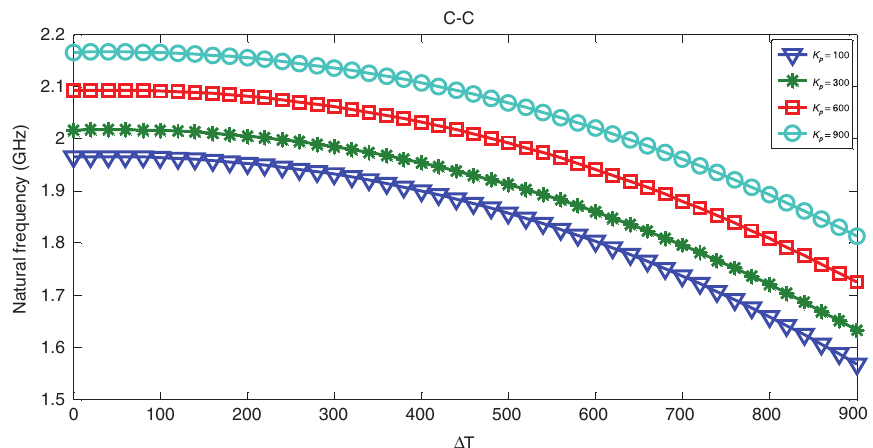
Figure 9: The effect of Pasternak stiffness on the natural frequency with clamped-clamped boundary condition.